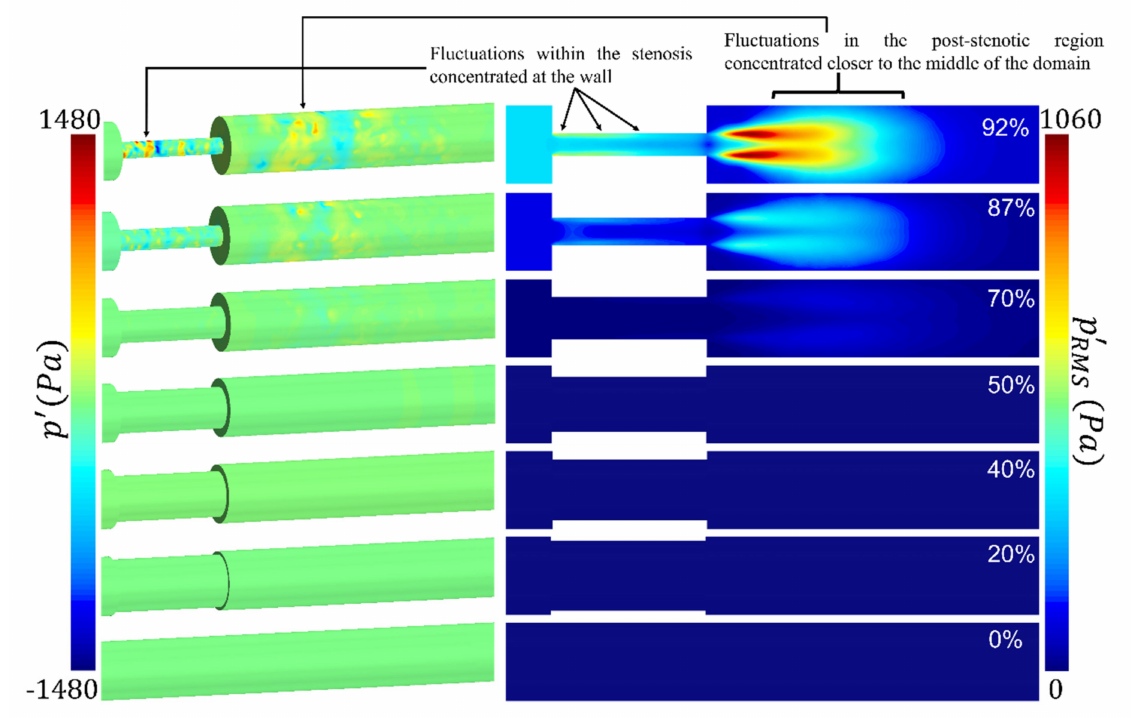
Figure 6. Pressure fluctuations on the arterial wall and root-mean-square (RMS) of pressure fluctuations on the middle cross-section of the flow domain showing the concentration and high-energy fluctuation through and downstream of the